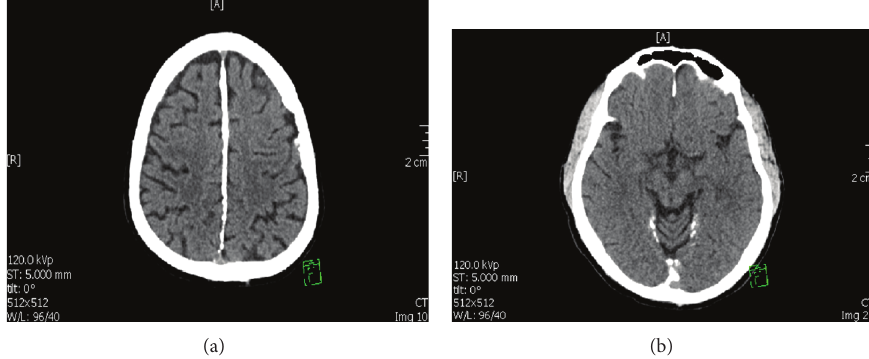
Figure 2: An axial brain CT scan showing extensive brain calcifications along falx cerebri (a) and around the cerebellar vermis with few tiny calcifications in the cerebellum bilaterally